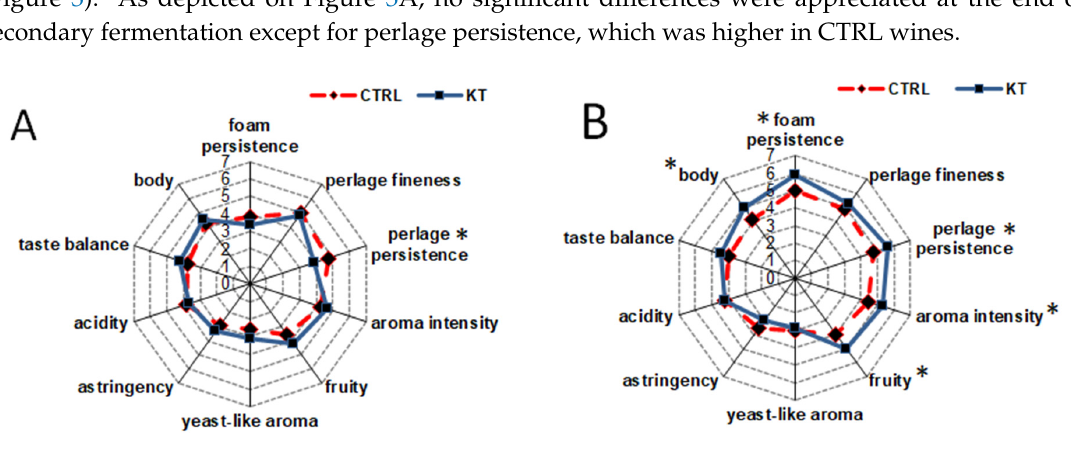
Figure 3. Sensory evaluation of sparkling wines after secondary fermentation ( A ) and 12 months of ageing “sur lie” ( B ). * Indicates significant differences according to Tukey’s test ( p < 0.05).